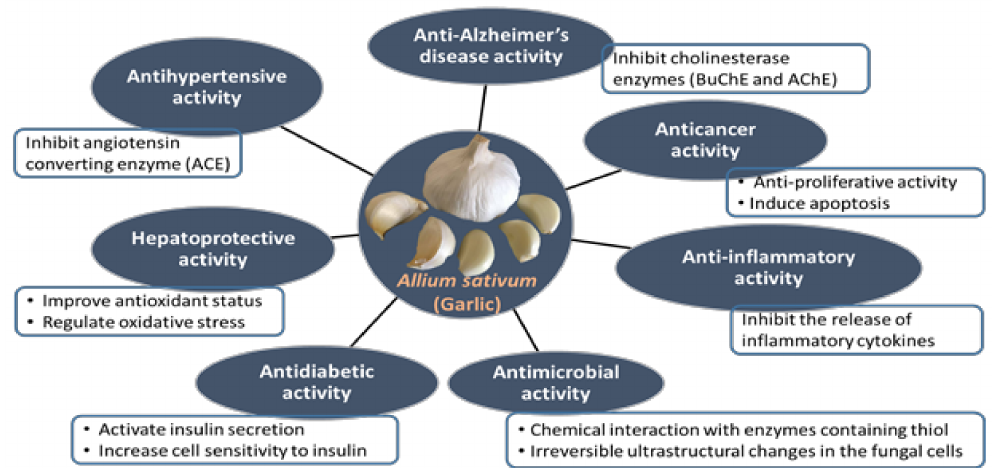
Figure 1. Schematic representation of di ff erent pharmacological activities of garlic ( Allium sativum ) and their